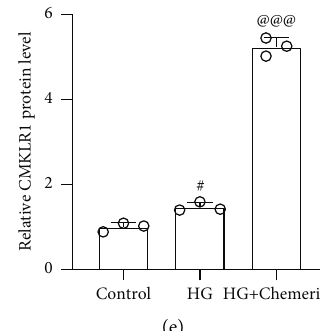
Figure 4: Chemerin activated CMKLR1 and aggravated high glucose-induced cell injury in ARPE-19 cells. (a) ARPE-19 cells were exposed to different concentrations of D-glucose (0–100mM) treatment for 24h, and then cell viability was evaluated by MTT. 30mM was taken as high glucose (HG) concentration to stimulate ARPE-19 cells for further studies. (b) ARPE-19 cells were exposed to different concentrations of recombinant human chemerin and 30mM HG for 24h, and then cell viability was evaluated by MTT. 10nM recombinant human chemerin was chosen for further experiments. N � 6 for each group. After 24 exposure, RT-qPCR was used to measure the mRNA levels of CMKLR1, and western blot was used to measure the protein levels of CMKLR1 (c–e). N � 3 for each group. # p < 0 . 05, ## p < 0 . 01, and ### p < 0 . 001 compared to control, @ p < 0 . 05 and @@@ p < 0 . 001 compared to HG group. One-way ANOVA followed by Dunnett’s T3 multiple comparisons test.